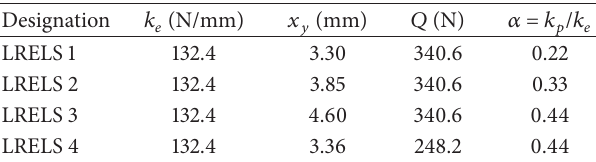
Table 2: Parameters of model isolators in the in-plane horizontal